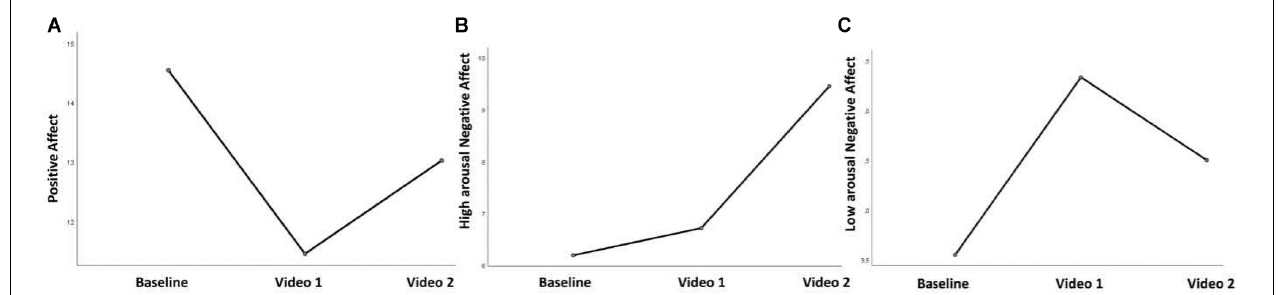
FIGURE 4 | Self-reported changes in Positive Affect (A) , high-arousal Negative Affect (B) , and low-arousal Negative Affect (C) in response to two